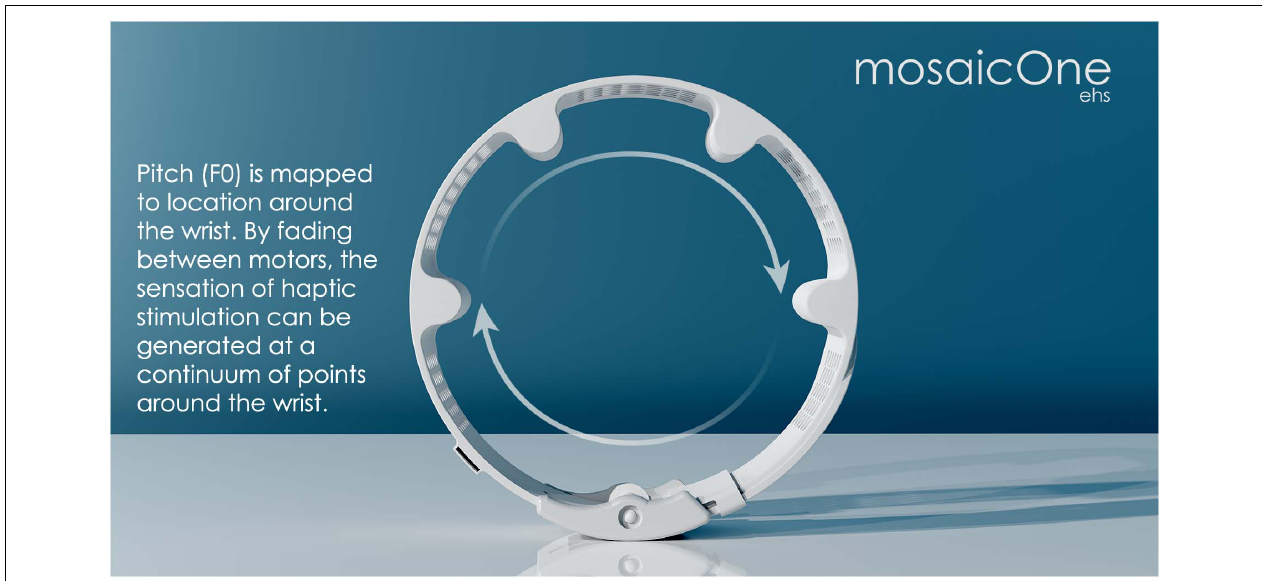
FIGURE 3 | Image of the mosaicOne_C device currently being developed at the University of Southampton as part of the Electro-Haptics Project. Text and arrows highlight that the device has four motors (extruding from the wristband), which are faded between to create the sensation of haptic stimulation at continuum of points around the wrist. Image reproduced with permission of Samuel Perry and Mark